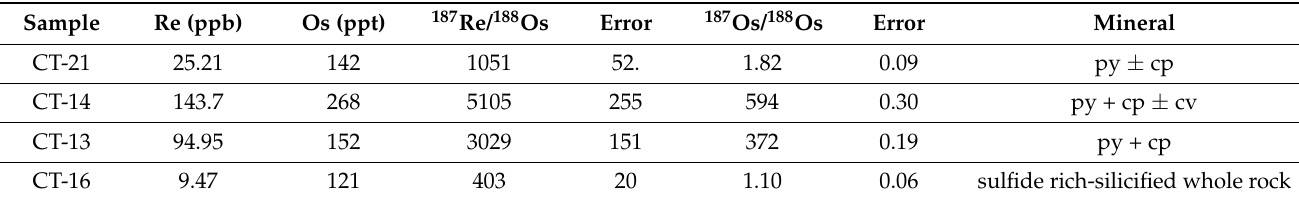
Table 1. Re, Os concentrations 187 Re / 188 Os, 187Os / 188 Os ratios with error margin of massive sulfide ores from drill Core samples of Cerattepe VMSD.